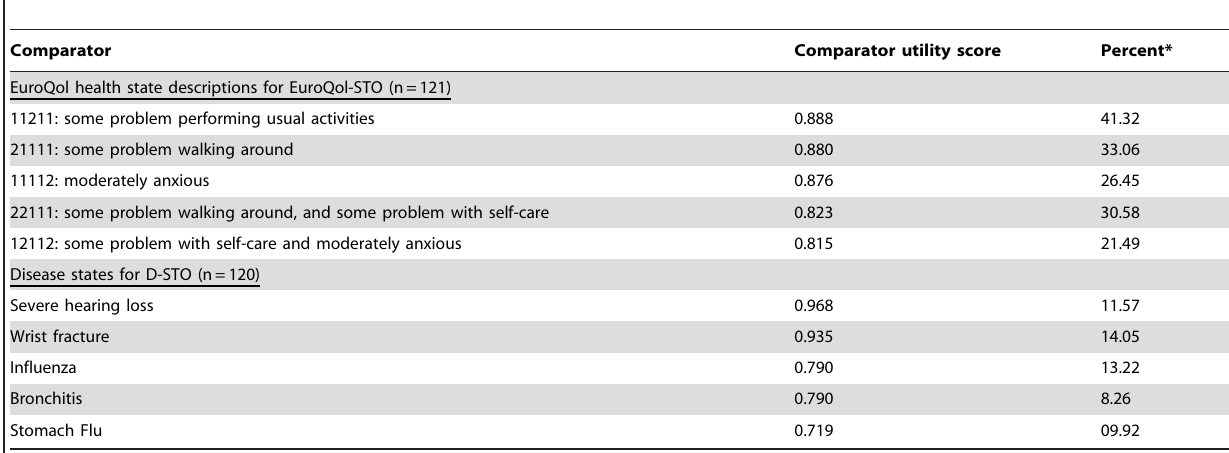
Table 5. Percentage of respondents rating an average day with mosquitoes during the summer of 2010 as worse than each comparator